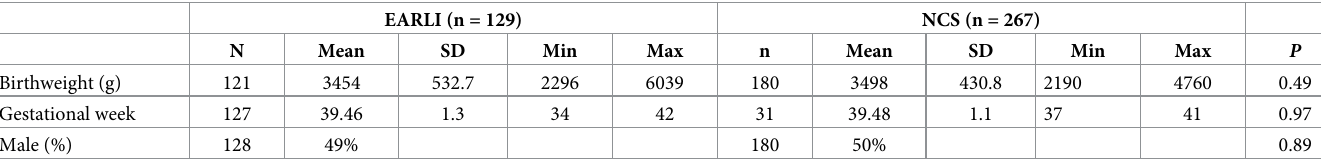
Table 2. Perinatal characteristics by